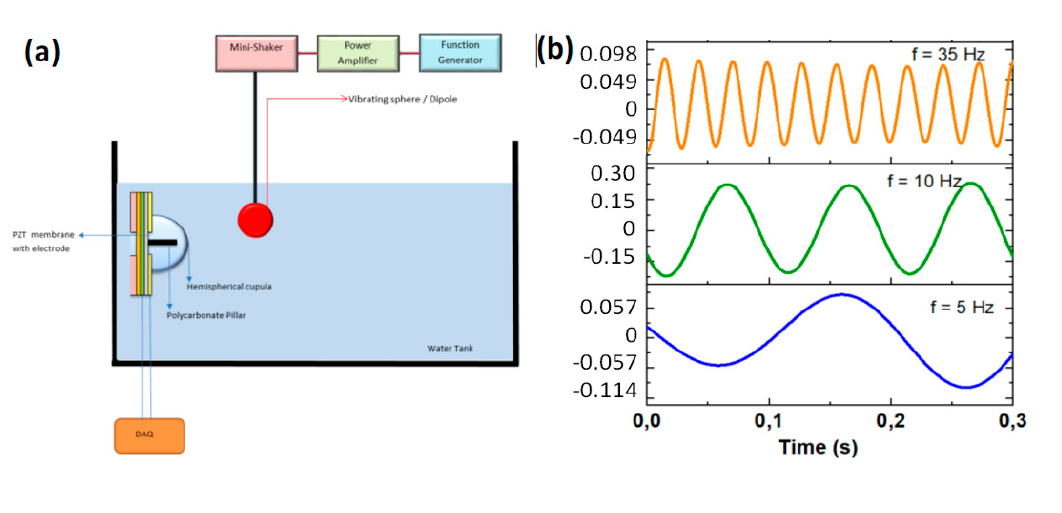
Figure 4. ( a ) Schematic of the experimental setup for testing the oscillatory response of MEMS CN sensor. ( b ) Response of the CN sensor to three different dipole stimulus